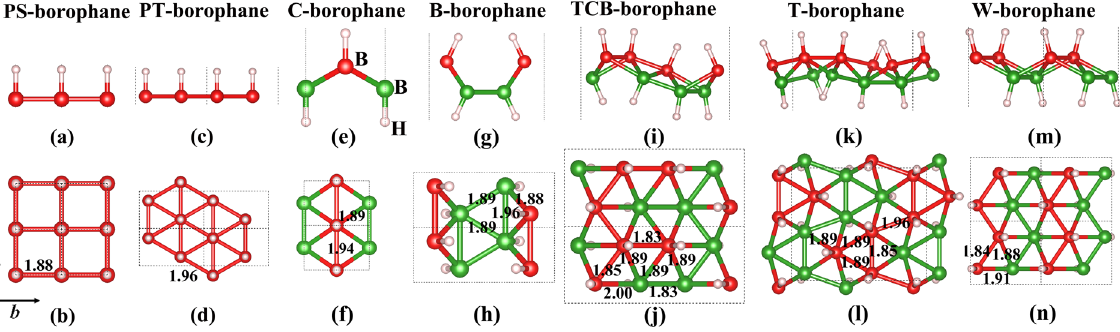
Figure 3. Crystal structure of seven borophane conformers. ( a ) Side view with b - c plane shown, ( b ) top view of atomic structure of PS-borophane. ( c ) Side view with b - c plane shown, ( d ) top view of atomic structure of PT-borophane. ( e ) Side view with b - c plane shown, ( f ) top view of atomic structure of C-borophane. ( g ) Side view with b - c plane shown, ( h ) top view of atomic structure of B-borophane. ( i ) Side view with b - c plane shown, ( j ) top view of atomic structure of TCB-borophane. ( k ) Side view with b - c plane shown, ( l ) top view of atomic structure of T-borophane. ( m ) Side view with b - c plane shown, ( n ) top view of atomic structure of W-borophane. The numbers are the B-B bond lengths in Å. The big red and green balls represent B atoms, the small light pink balls represent H atoms, respectively.